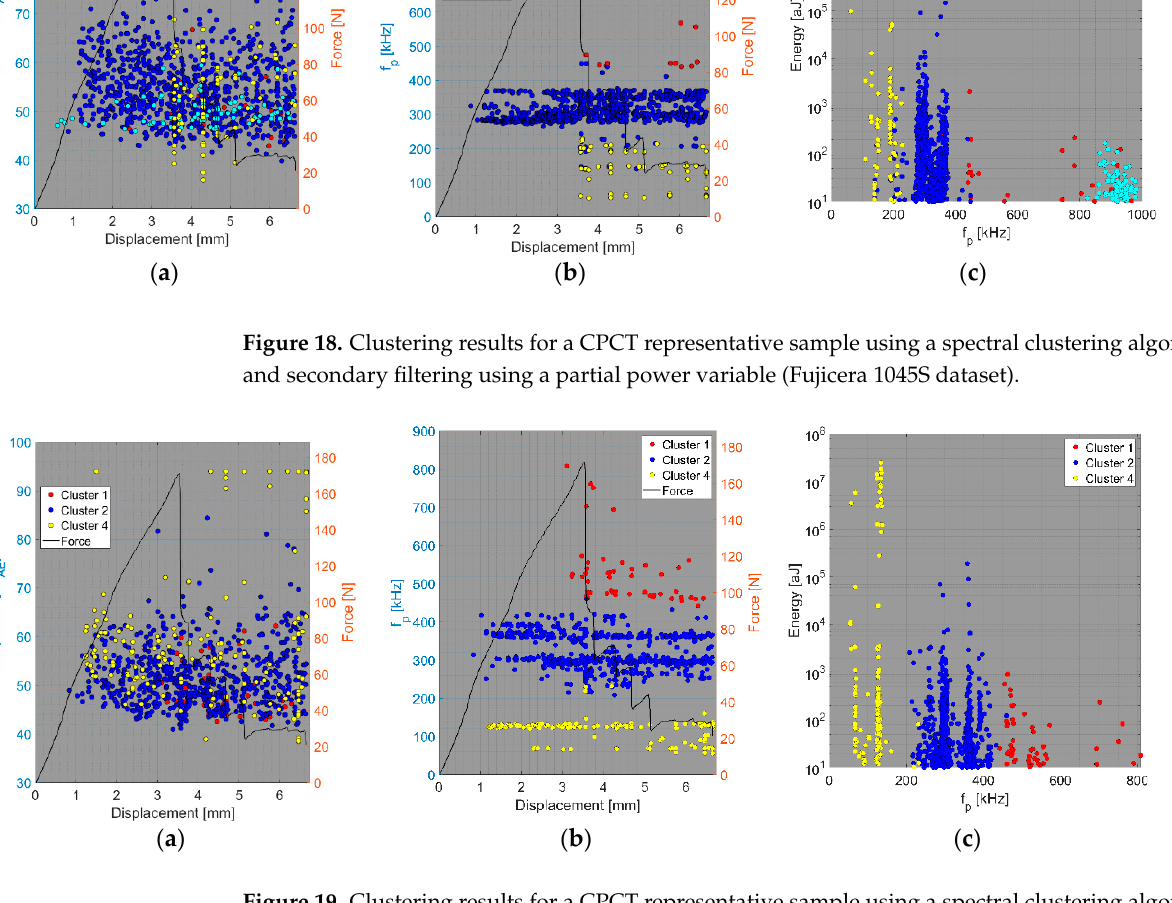
Figure 19. Clustering results for a CPCT representative sample using a spectral clustering algorithm (DWC 454